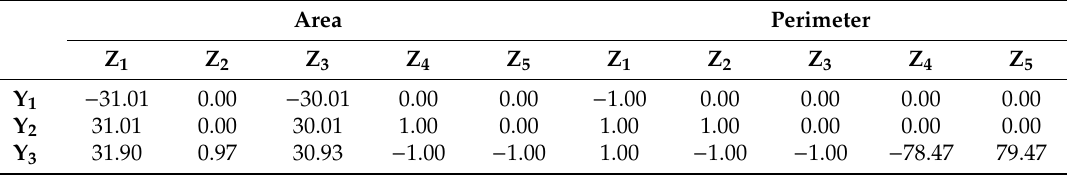
Table 8. Layer weight for area and perimeter features.